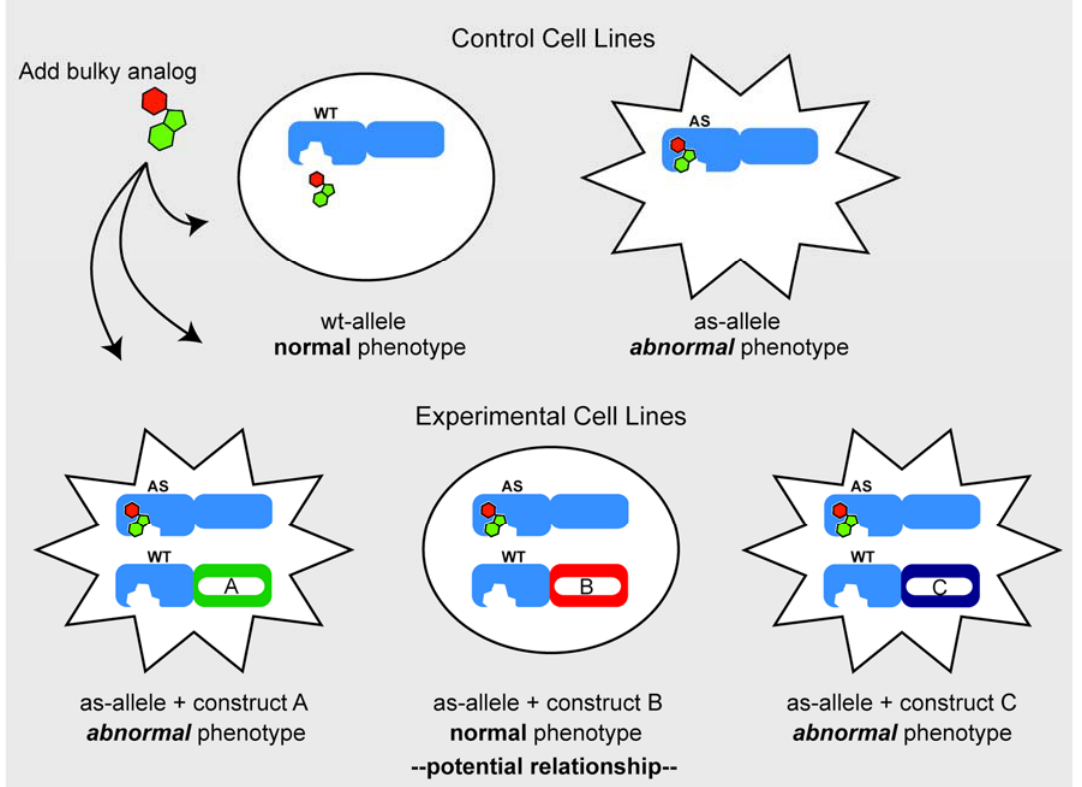
Figure 4. Assay for fusion construct complementation. Challenging cells with the ATP analog inhibits the as-allele, producing an abnormal phenotype (illustrated here as starburst cell shape). Note the wildtype (WT) allele is resistant to the analog, maintaining a normal phenotype. In cells expressing the fusion constructs, rescue of a normal phenotype suggests a functional relationship between the kinase and candidate